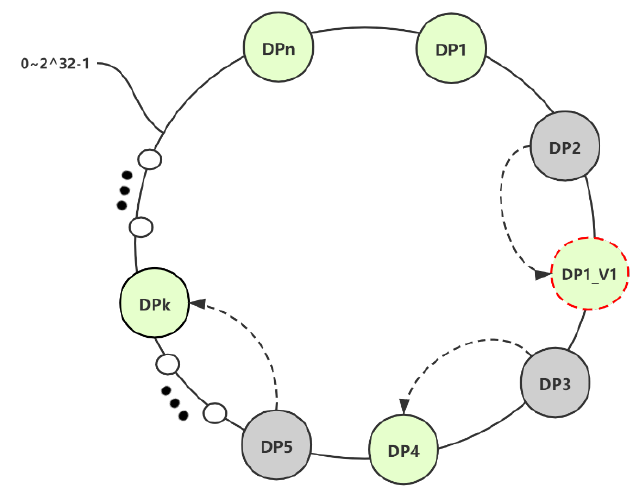
Figure 2. Ring topology with virtual